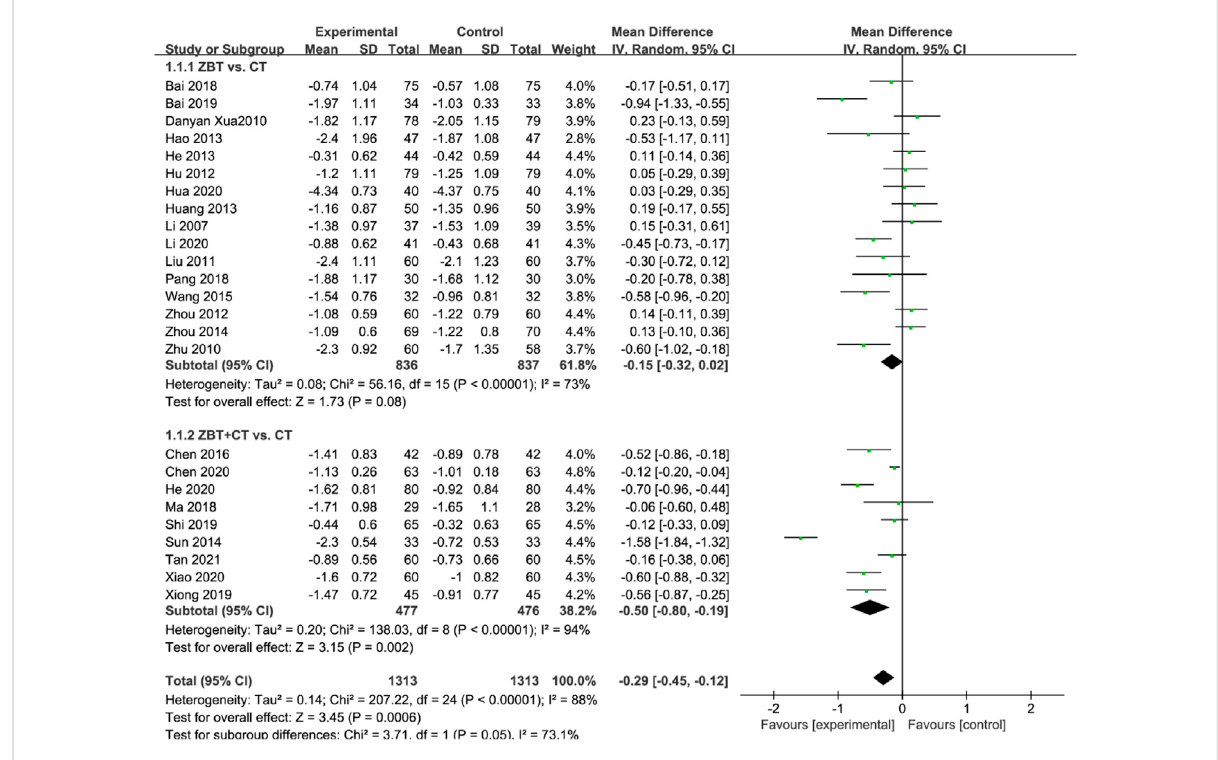
FIGURE 3 Meta-analysis results of the effect of Zhibitai (ZBT) vs. conventional therapy (CT) on total cholesterol (TC)